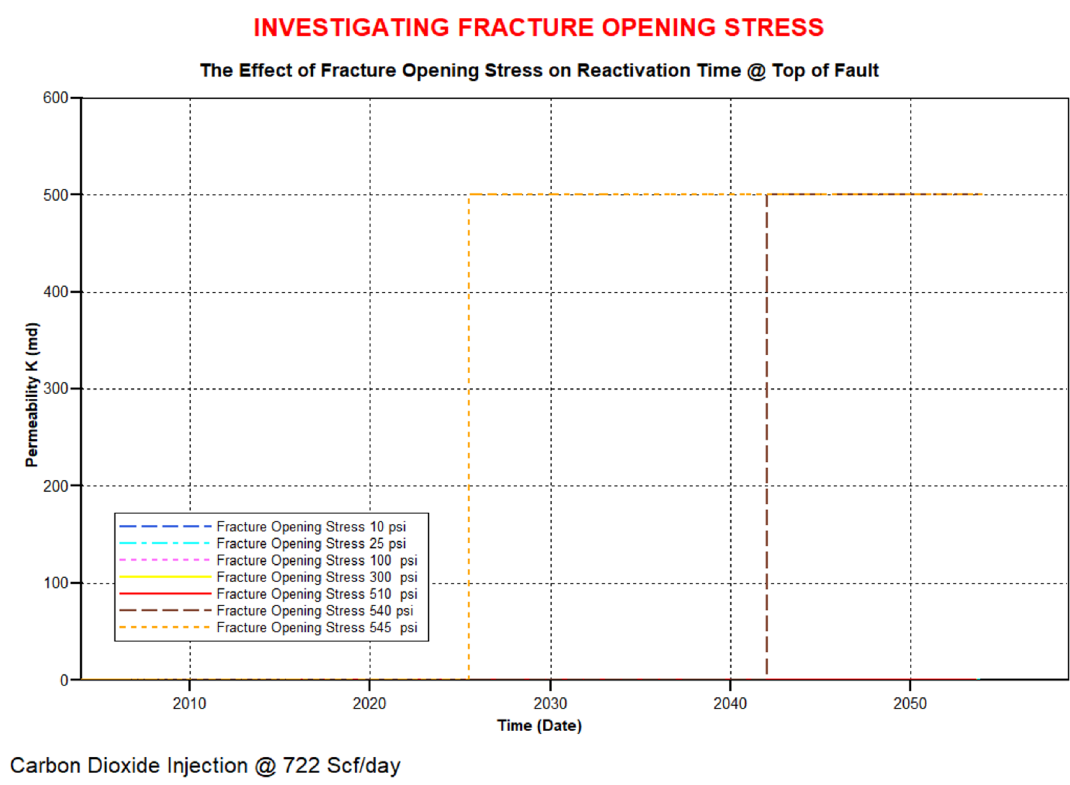
Fig. 15 Time taken for onset of fault reactivation at the top of the fault for varying fracture opening